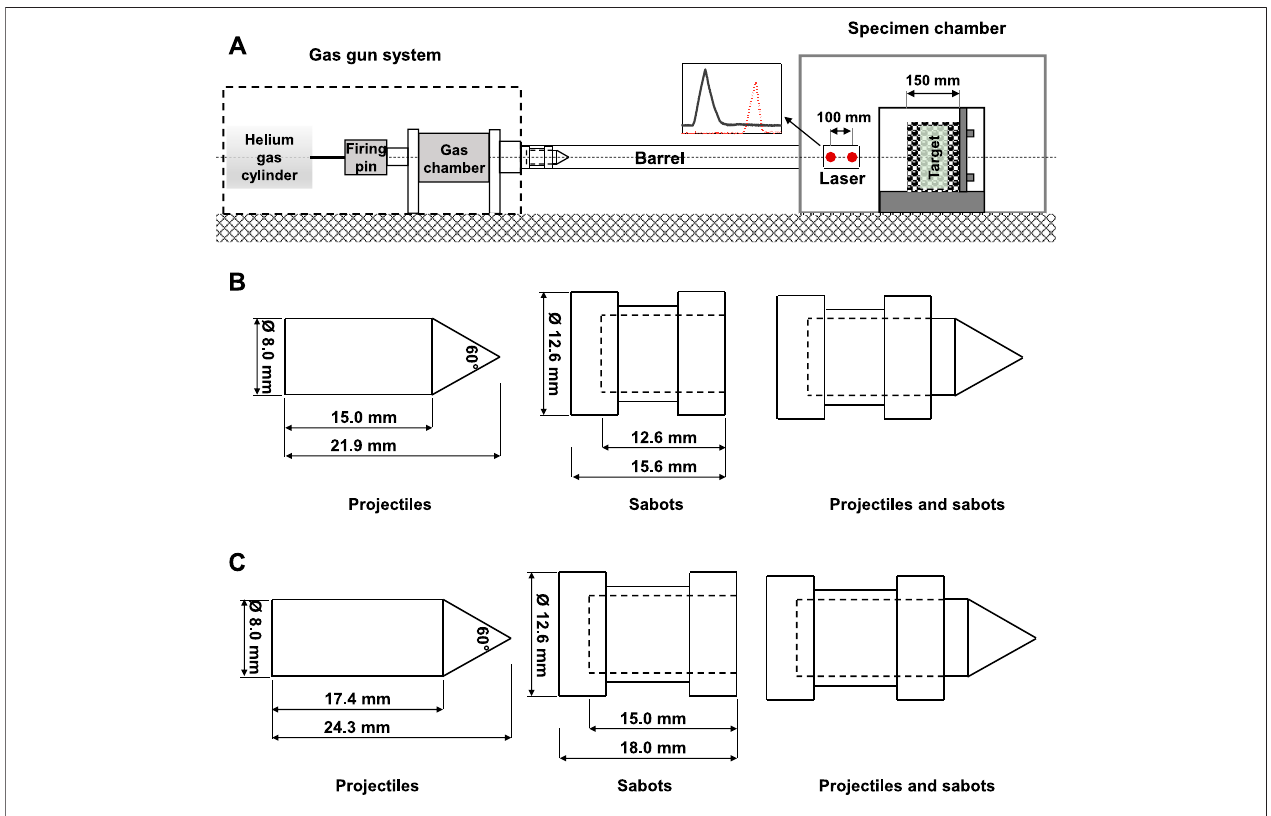
FIGURE 1 | Schematic of (A) HVPI test setup, (B) copper, and (C) steel projectile and their sabot.